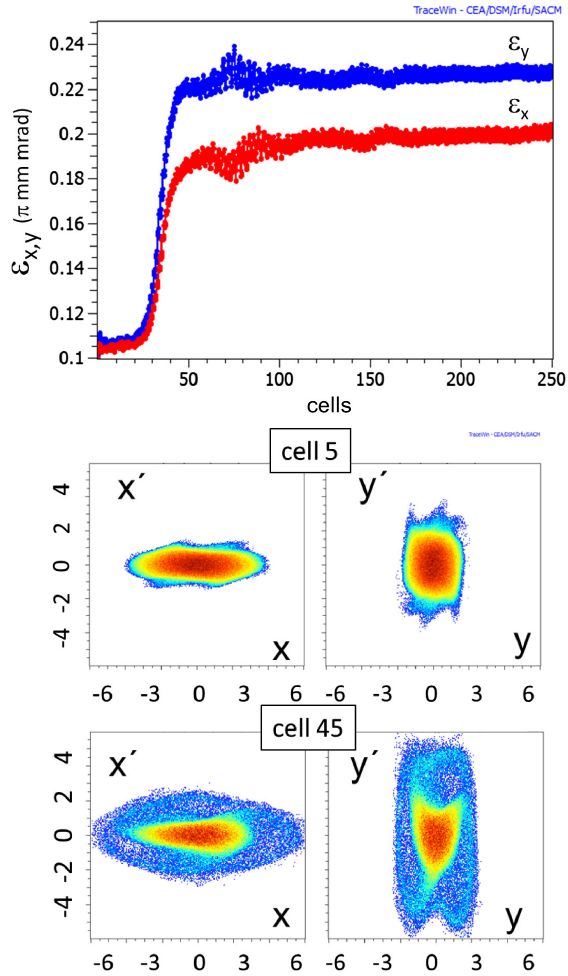
FIG. 10. Top graph: rms emittances versus cell number for k ¼ 90 °, k ¼ 41 . 5 ° for waterbag distribution. Bottom 0 ;x;y x;y graph: phase space plots at cells 5 and